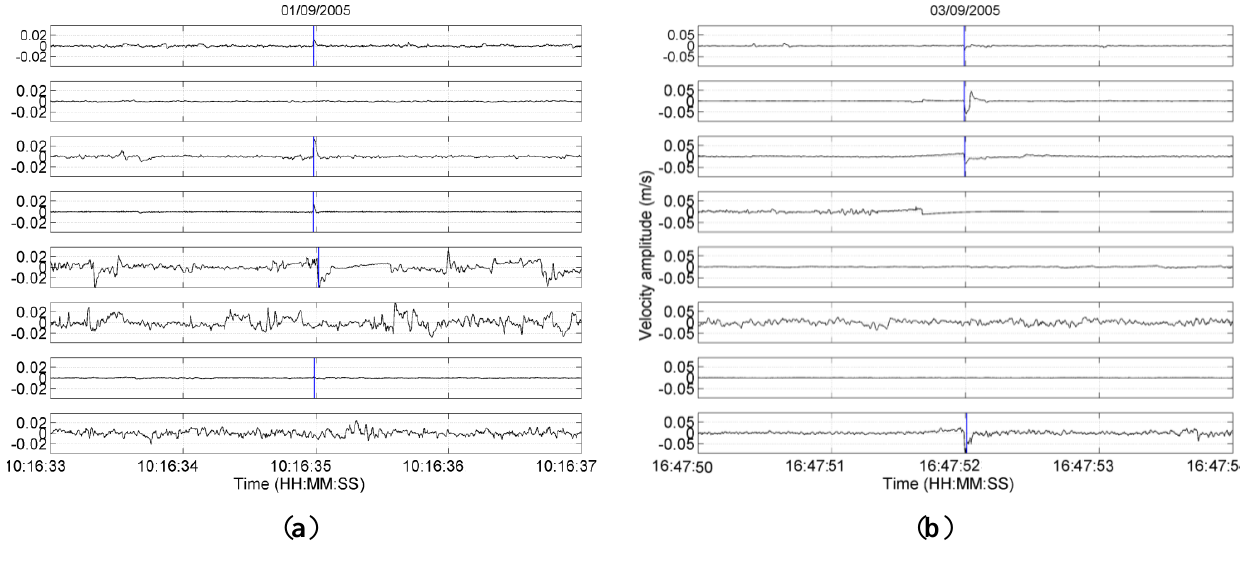
Figure A1. Examples of signals identified by the STA/LTA observed during the two-week time period analysed in this study. Each subfigure shows the vertical components of geophones 1 to 8 from bottom to up. Date of the detection appears in the top of each plot (dd/mm/yyyy). Each trace is normalized by the maximum of and interval which covers 0.1 s before and after the detection. ( a – c ): Examples of detections from Type-F events. ( d ): Type-A event with the largest amplitude registered in geophone g.3. ( e ) Type-B event at the edge of a period without recording (typical recording for the last days of the two-week period). ( f ) Type-E event in which periodic signals appear in